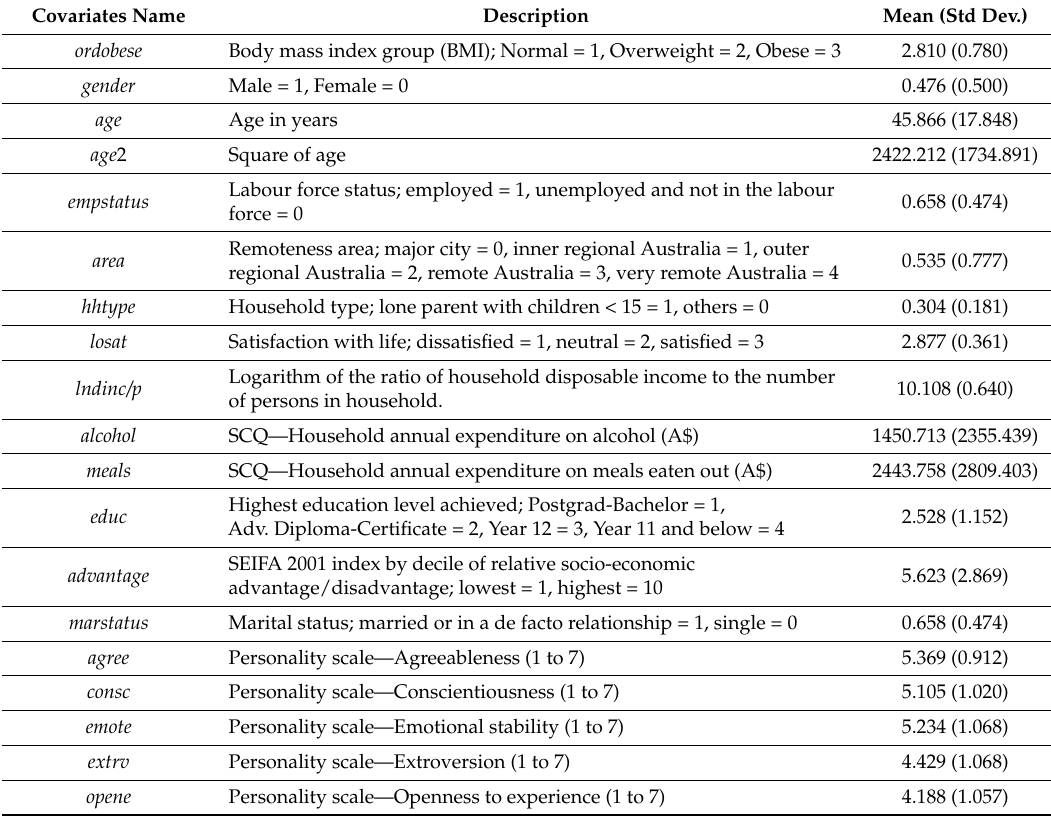
Table 1. Description and descriptive statistics for the covariates used in the